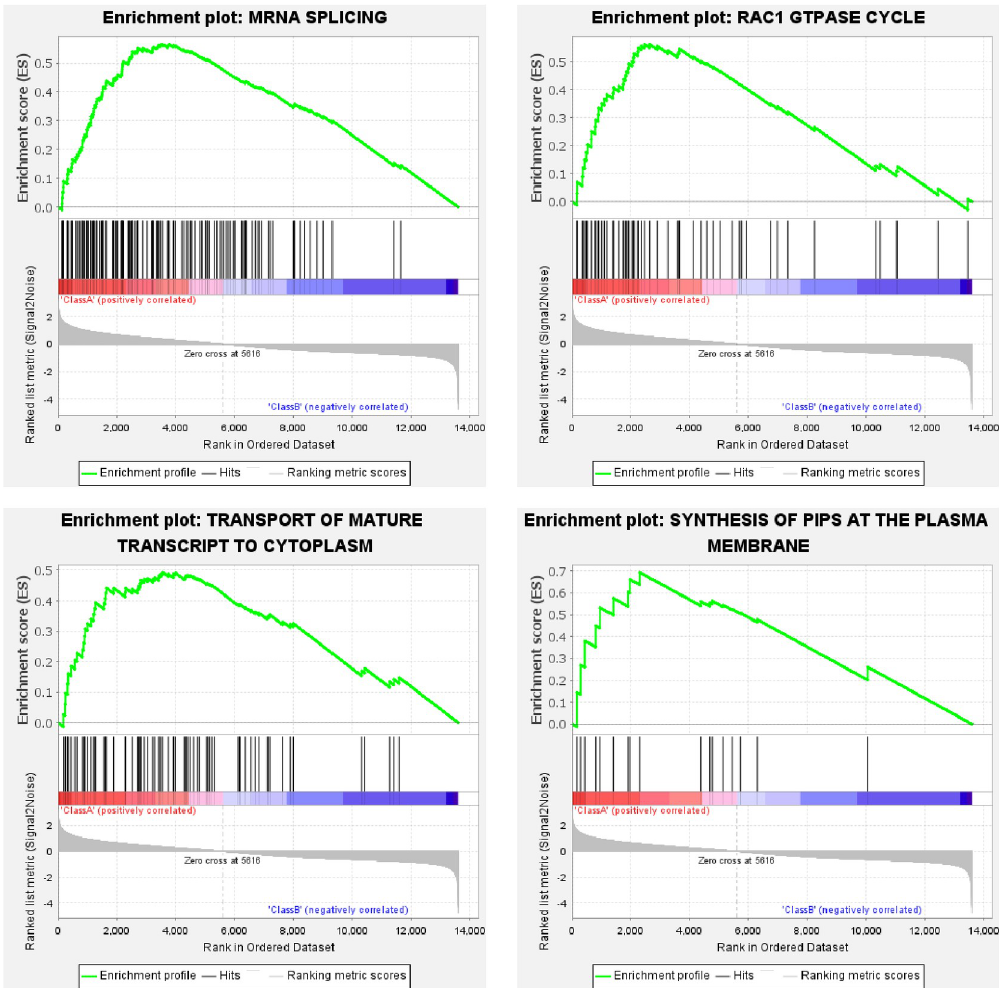
Fig 2. Representative Reactome enrichment plots of the ELAV group. For each plot, the upper part shows the enrichment score; while the lower part shows ranked list metric of the gene set. The middle part shows the ranked gene list, with red meaning upregulation, blue for downregulation, and black vertical line for the genes of the